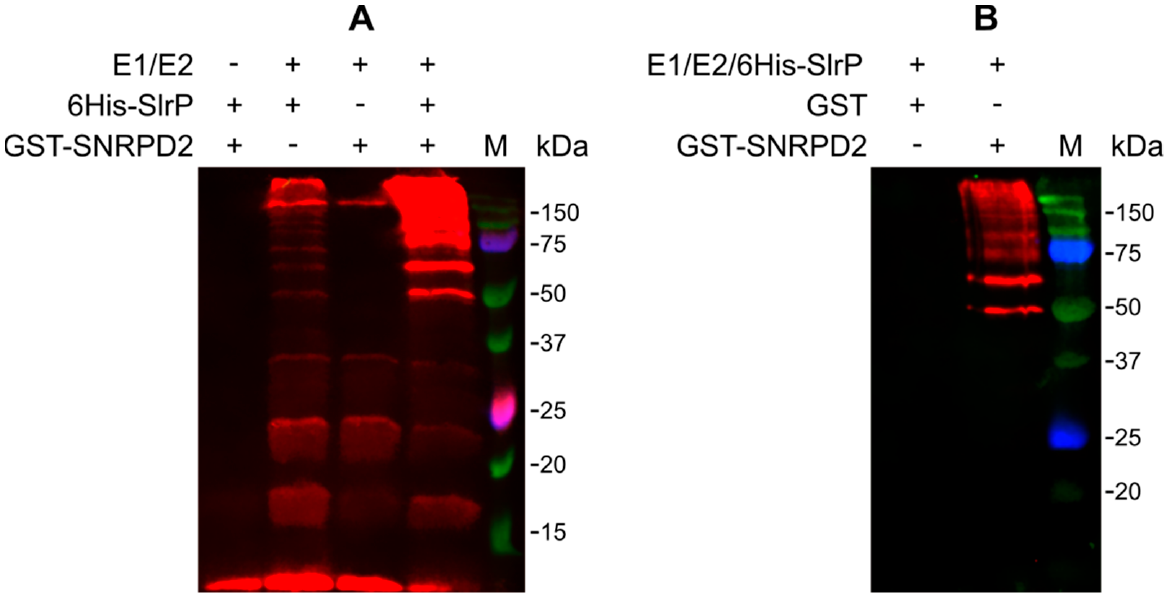
Figure 3 . In vitro ubiquitination of SNRPD2 catalyzed by SlrP. ( A ) Ubiquitination reactions carried out with HA-ubiquitin in the presence (+) or absence ( − ) of E1, E2, 6His-SlrP, and GST-SNRPD2, were submitted to immunoblot analysis with anti-HA monoclonal antibodies. ( B ) Ubiquitination reactions were carried out with GST or GST-SNRPD2 bound to glutathione-agarose beads, washed and subjected to immunoblot analysis with anti-HA monoclonal antibodies. Results shown are representative of three independent experiments.